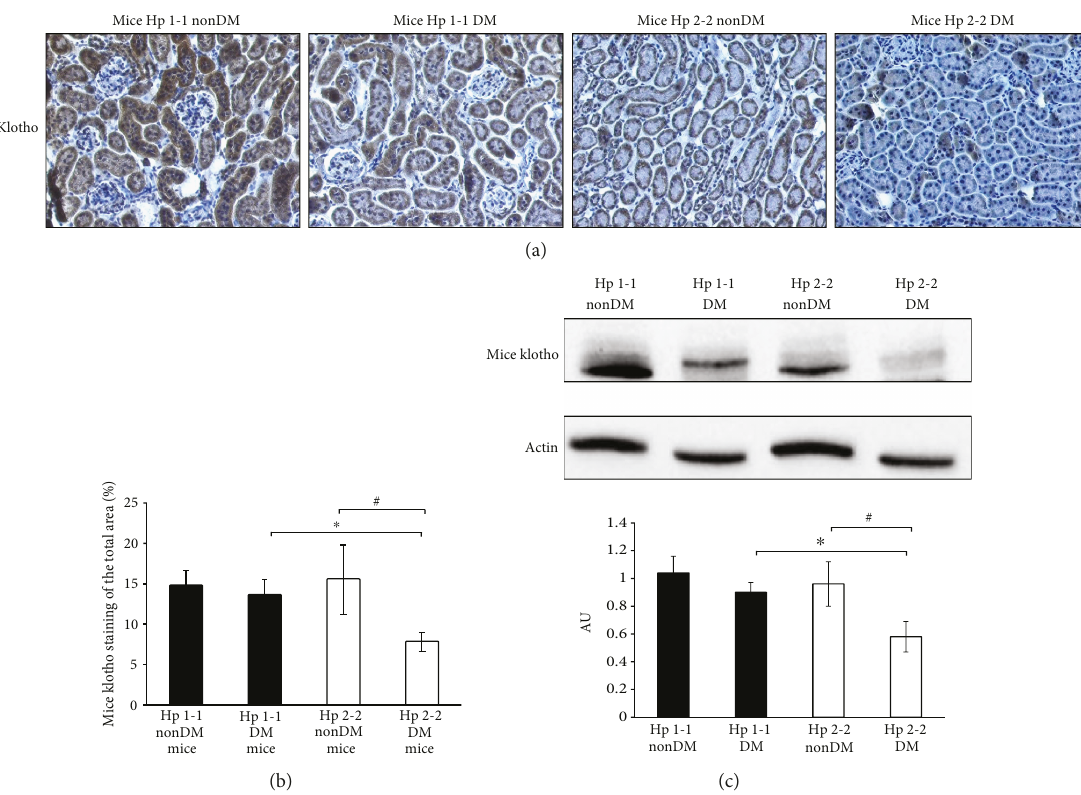
Figure 3: (a) α -Klotho renal expression in nondiabetic and diabetic nephropathy mice. (b) The percentage of the α -klotho-stained area is signi fi cantly decreased in the renal tubules of Hp 2-2 diabetic (DM) sections compared with Hp 1-1 diabetic ( ∗ p < 0 05 ) or with nondiabetic (nonDM) Hp 2-2 sections ( # p < 0 05 ). (c) α -Klotho expression in mice renal lysates from Hp 1-1 and Hp 2-2 nondiabetic (nonDM) and diabetic (DM) mice. Proteins were detected by immunoblotting with antibodies against α -klotho and actin. The values represent the mean ± SEM for 3 independent experiments subjected to 2-tailed, 2-sampled unequal variance Student ’ s t -test, with # p < 0 05 compared with Hp 2-2 nonDM and ∗ p < 0 05 compared with Hp 1-1 DM. AU: arbitrary